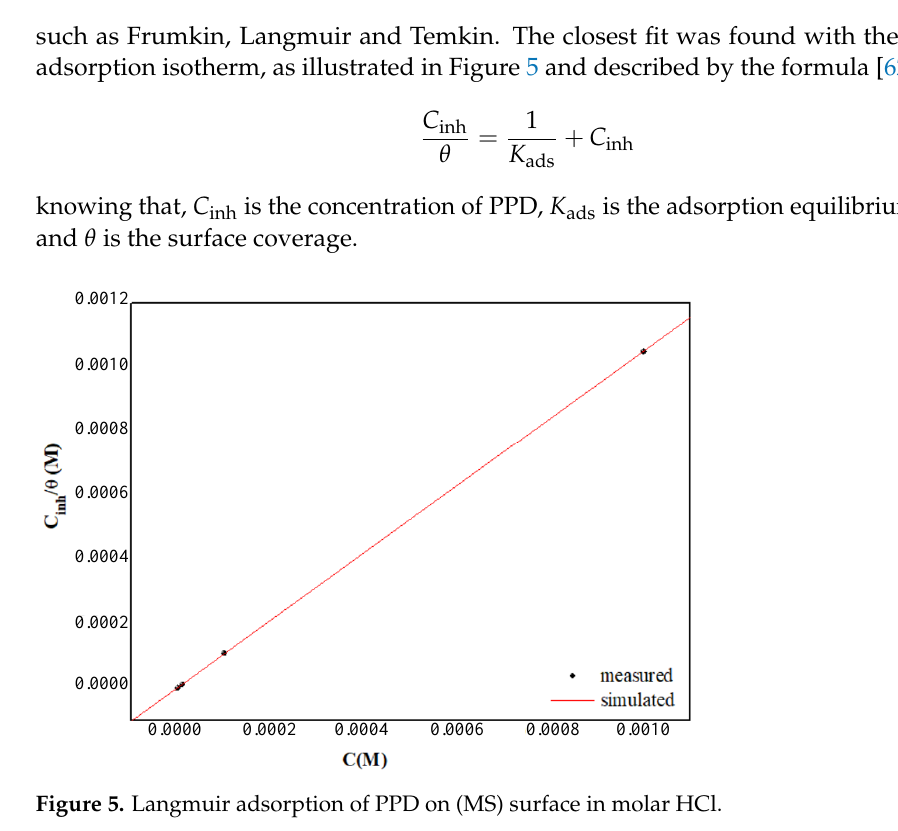
Table 5. Parameters of ( C/θ vs C ) and ( ∆ G 0 Compound Tested